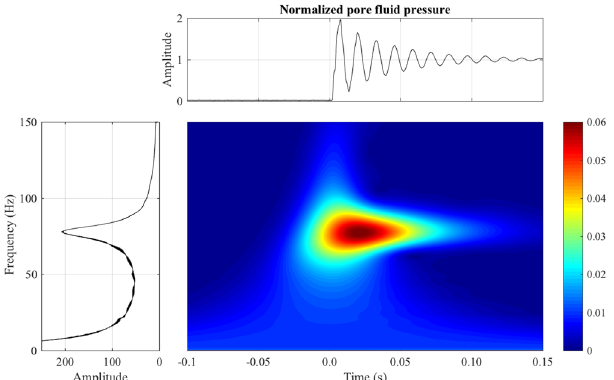
Figure 4. Continuous Cauchy wavelet transformation of the excess pore fluid pressure or intergranular stress with full destruction of saturated granular assembly (isotropic liquefaction U 3 ) at 212 kPa of confining pressure.